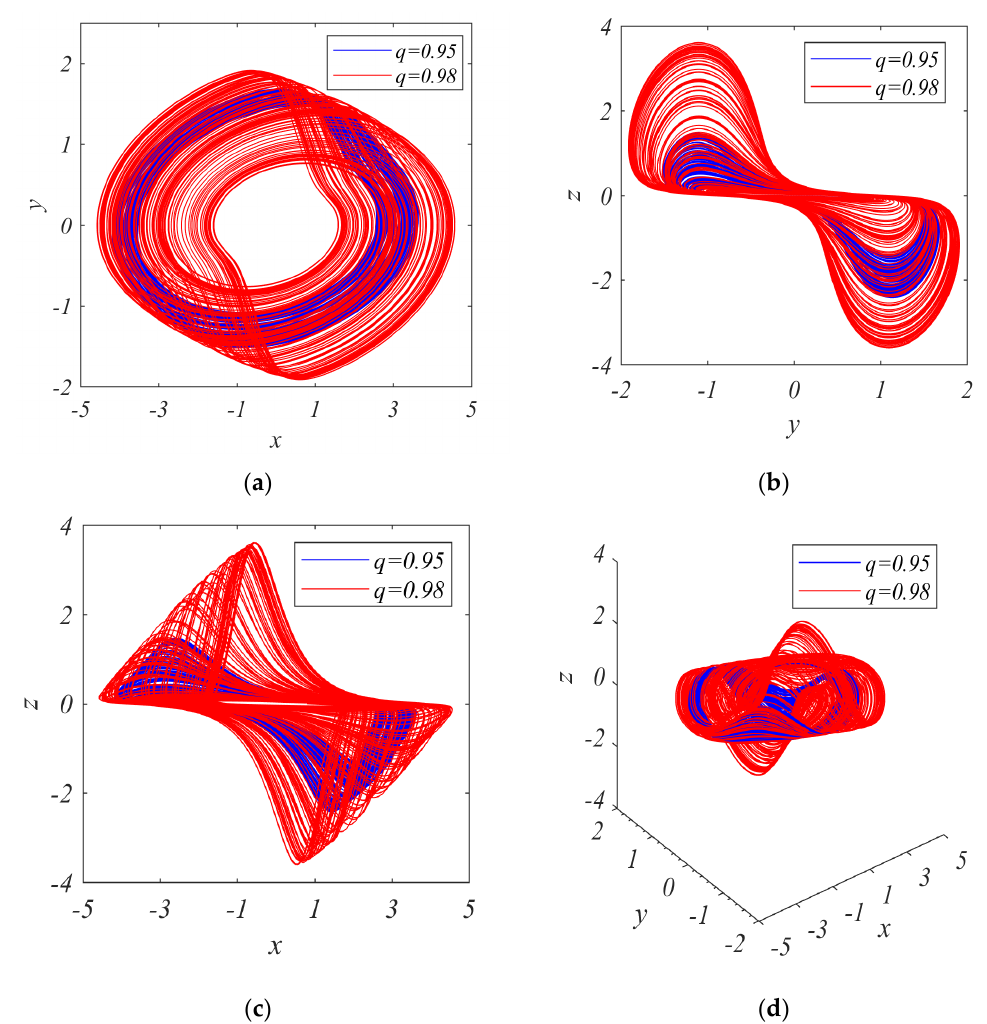
Figure 8. The chaotic attractors phase portraits of the fractional-order memristive chaotic system (14): ( a ) x - y ; ( b ) y - z ; ( c ) x - z ; ( d ) 3D arrangement ( x - y - z ).